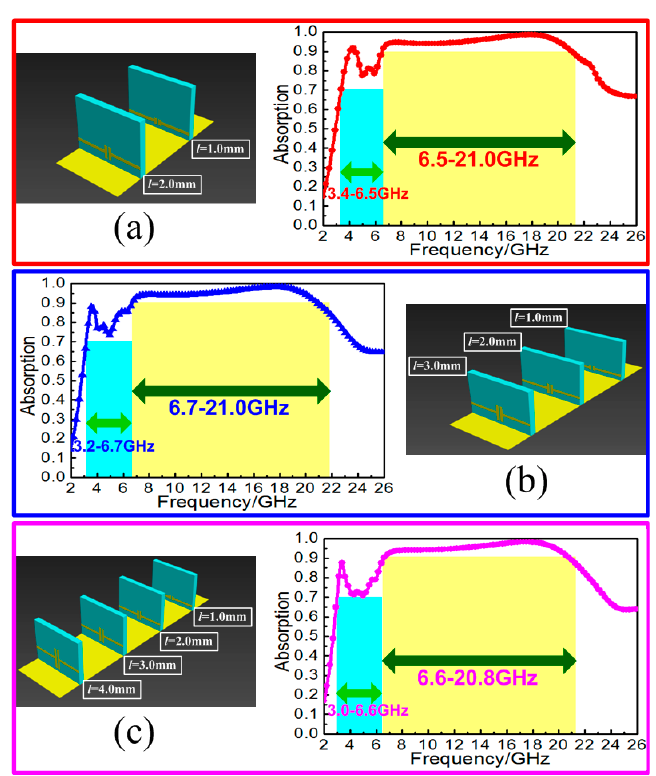
Figure 8. Structure diagram and simulated absorption spectra for the combination of: ( a ) two-units; ( b ) three-units; and ( c ) four-units.